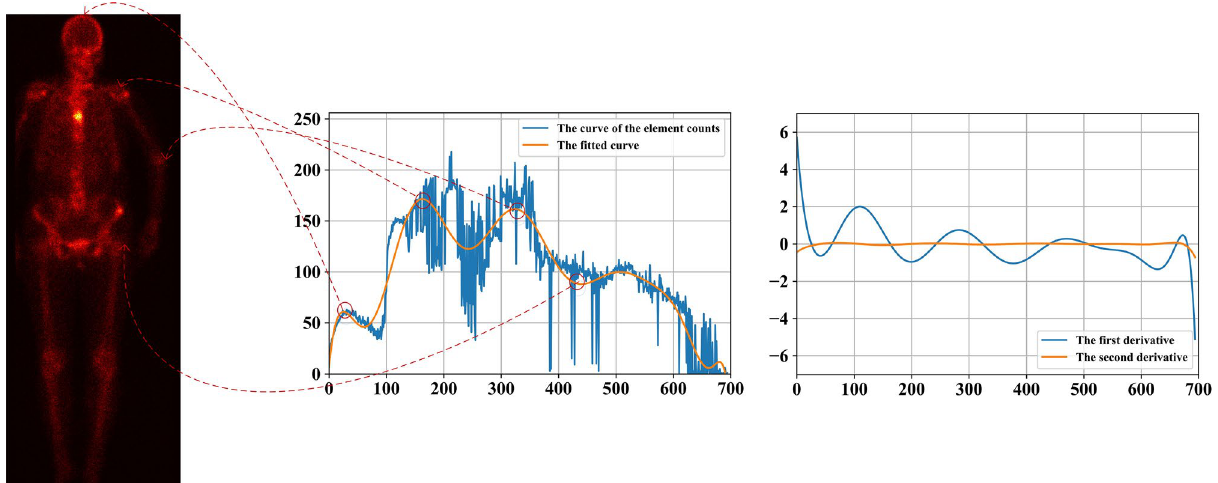
Figure 3. Cropping thoracic region based on curve fitting approach (left: the valid body area of a posterior SPECT image; middle: the fitted curve; and right: the curves of the first and second derivatives of the fitted